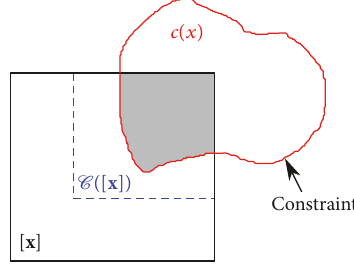
Figure 3: Contraction of a box by a contractor C